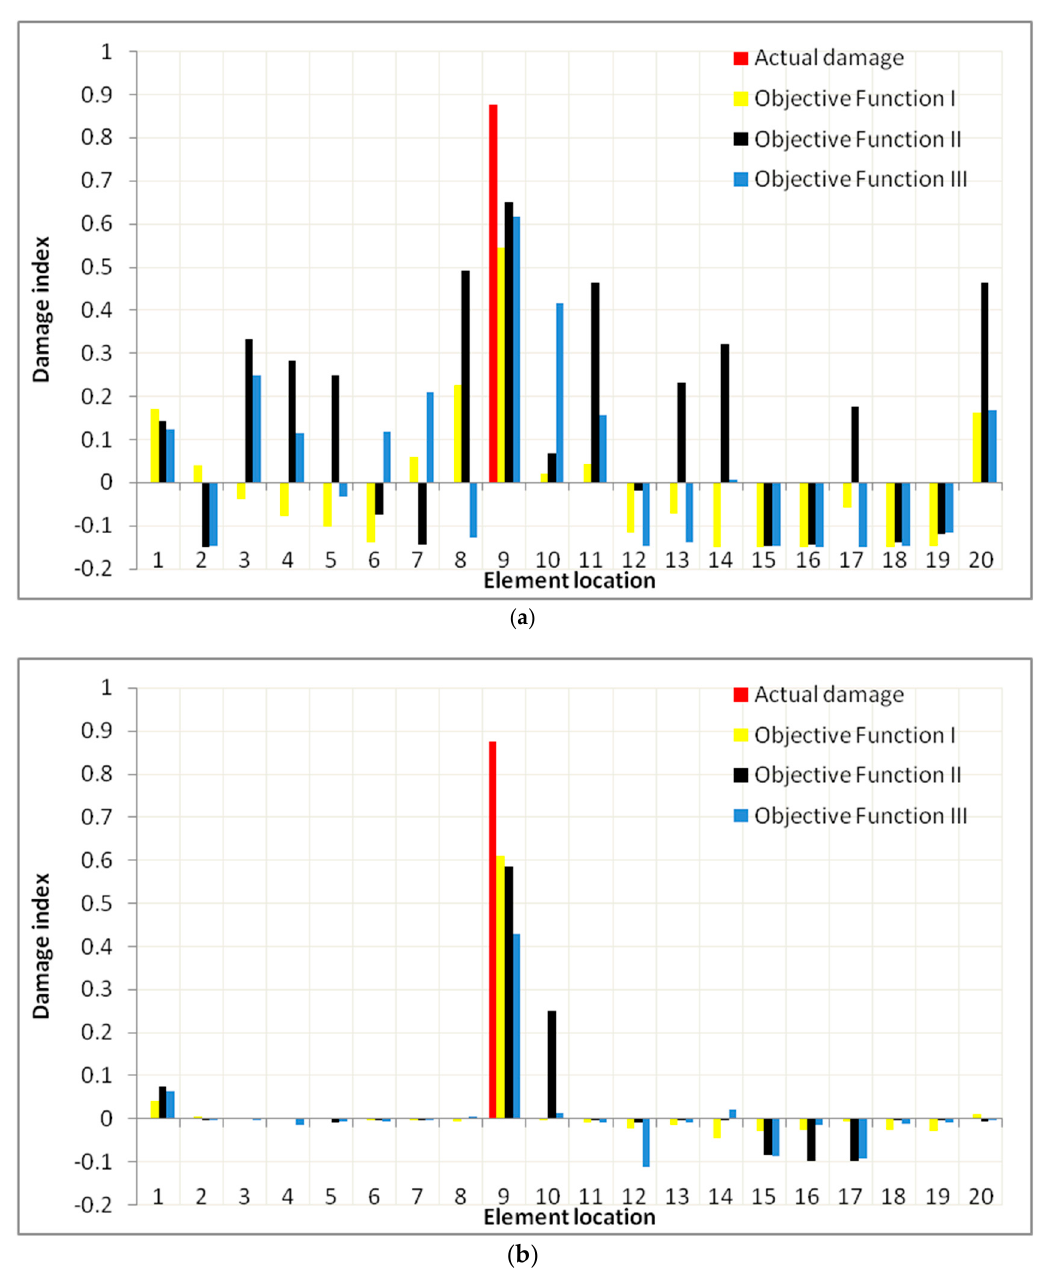
Figure15. Damage distribution for Case 3 using ( a ) Objective Functions I, II and III without regularization and ( b ) Objective Functions I, II and III with regularization.